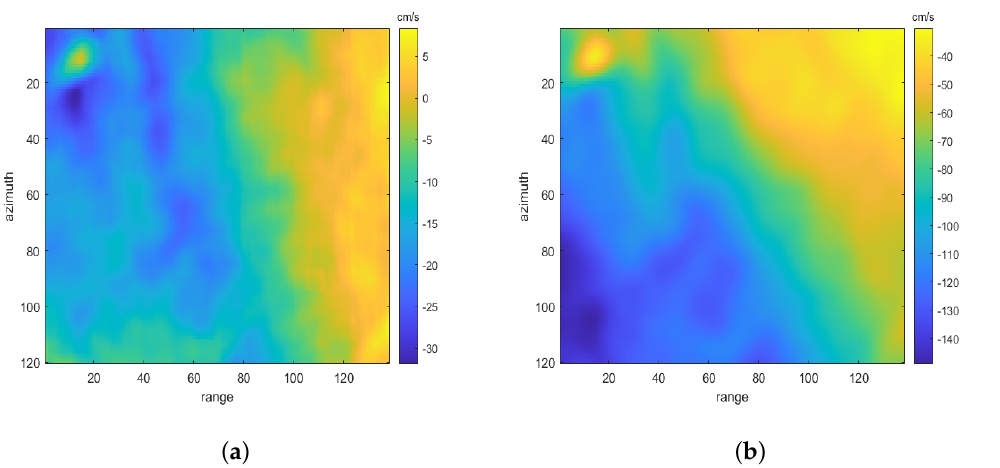
Figure 15. The ocean current retrieved by the ATI method. ( a ) The radial velocities of the ocean surface; ( b ) the ocean current